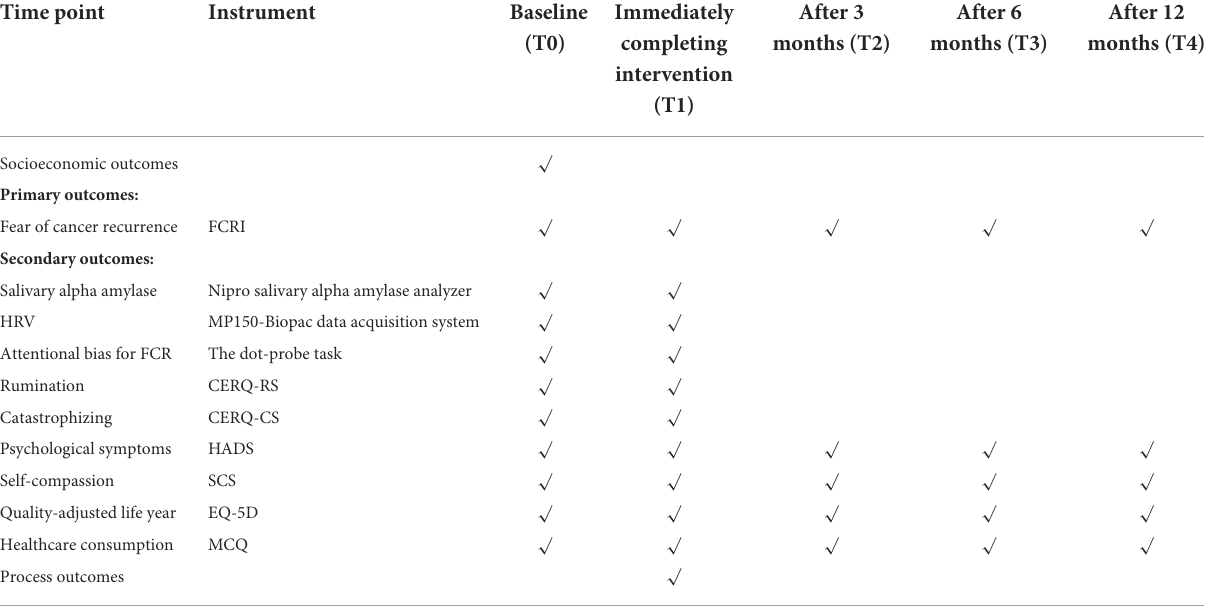
TABLE 2 Measurement time point. Time